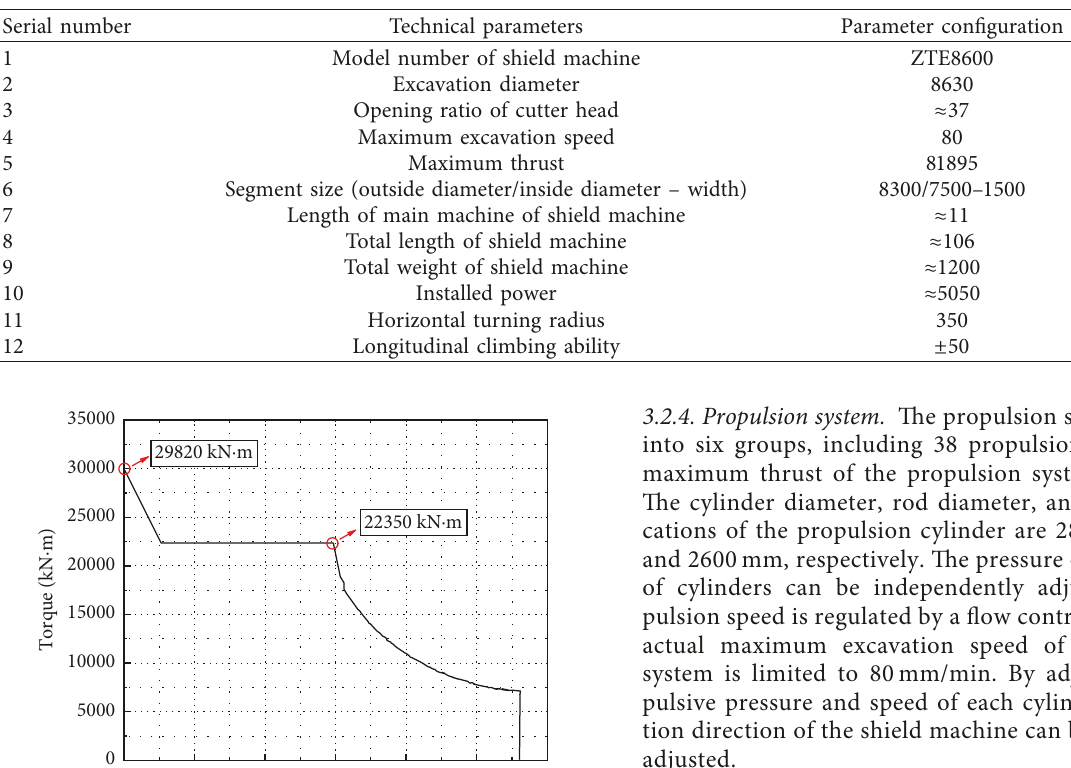
Table 1: Performance parameters of the shield machine.